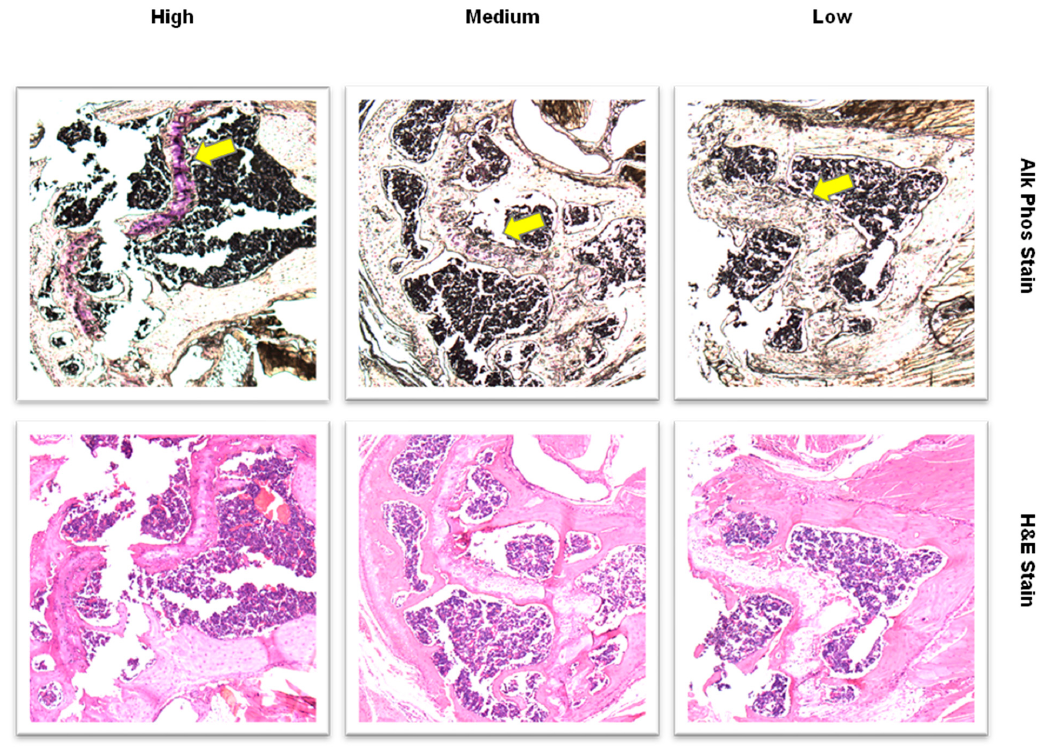
Figure 12. Histology images (10× magnification) of humerus sections at the distal epiphyseal plate from 3 mice. Purple areas identified with arrows show alkaline phosphatase staining of osteoblasts (top row). The images illustrate sections with high, medium and low staining. Hematoxylin and eosin-stained (H&E) images show cell structures within the sections (bottom row). Even though there was higher alkaline phosphatase activity within the epiphyseal plate of the control versus the HS groups, there was no significant difference in the thick- ness of the growth plates across the three treatment groups ( p = 0.16; Figure 14). Removal of the three outliers seen in Figure 13 from analysis changed the main effect of group to p = 0.06, with plate thickness being higher in the 15% HS compared to the control group. Growth plate thickness was not significantly related to osteoblast density score (R- squared = 0.05, p = 0.14).